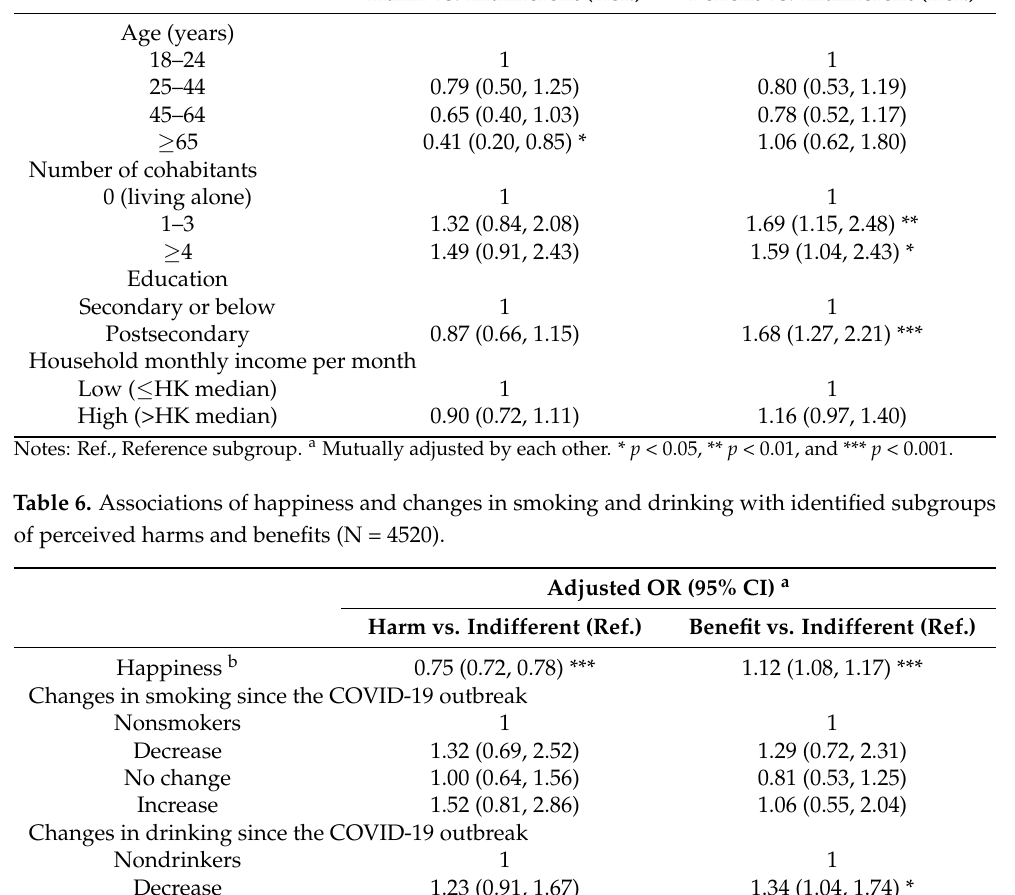
Adjusted OR (95% CI) a Harm vs. Indifferent (Ref.)